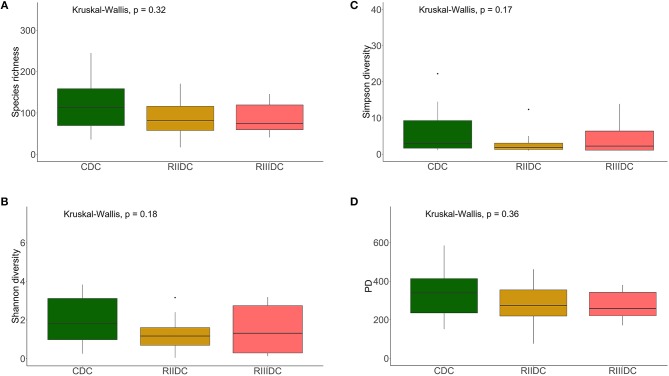
Diversity of the bacterial communities of the intestinal content. Boxplots show the species richness (A), Shannon index (B), Simpson index (C), and Faith's phylogenetic diversity (D). The feed group codes are as follows: Control, CDC; RII, RIIDC; RIII, RIIIDC.